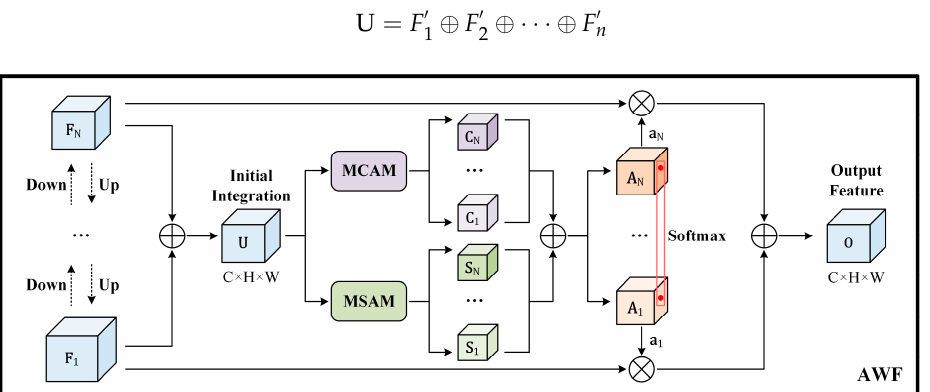
Figure 11. Diagram of the AWF. To generate the non-linear fusion weight a n , an element-wise softmax is performed on the integrated attention descriptors A n , fused by multi-scale channel attention C n and multi-scale spatial attention S n .